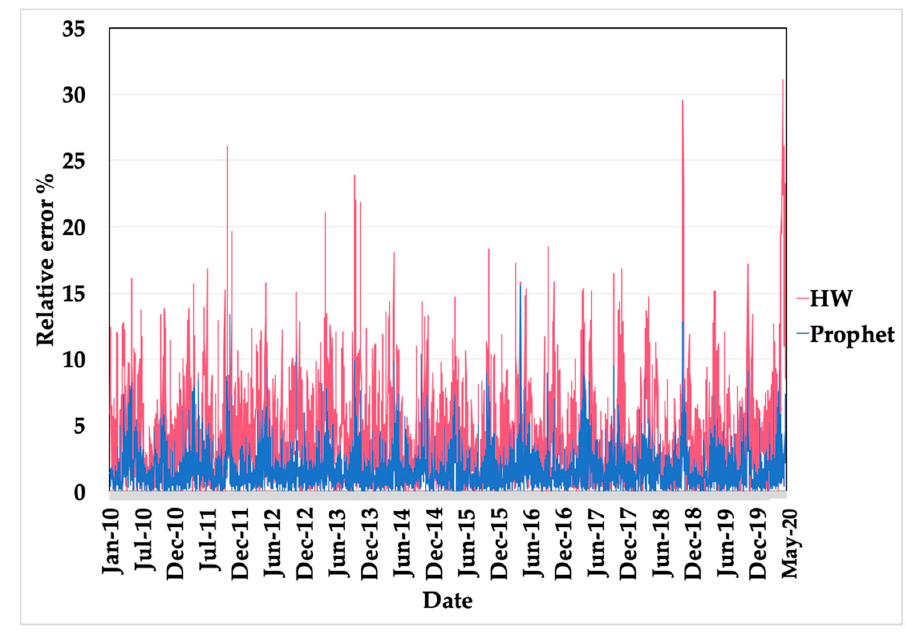
Figure 9. Relative errors percentage for Prophet and Holt–Winters